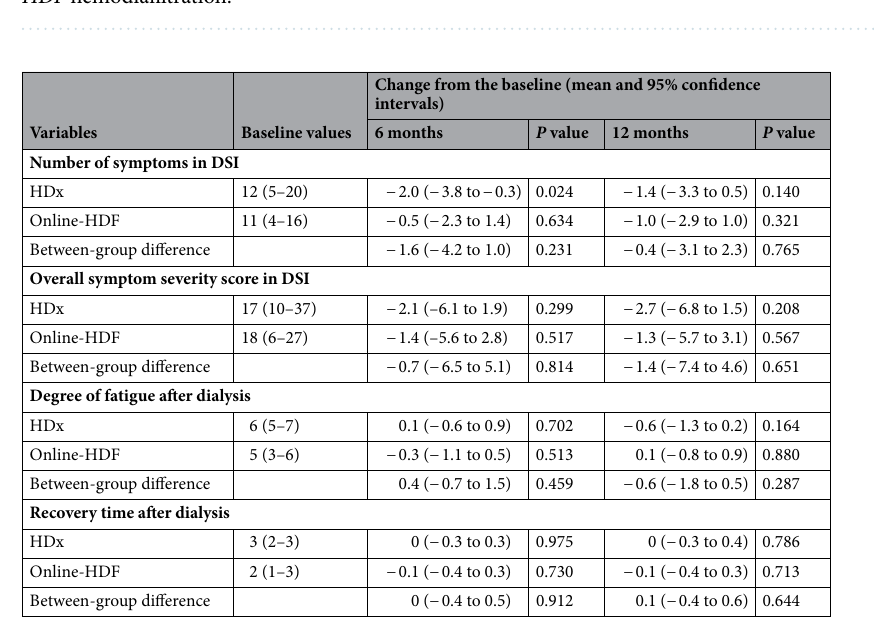
Figure 2. Kaplan–Meier curves of all-cause ( A ) and cardiovascular ( B ) survival. HDx expanded hemodialysis, HDF hemodiafiltration.